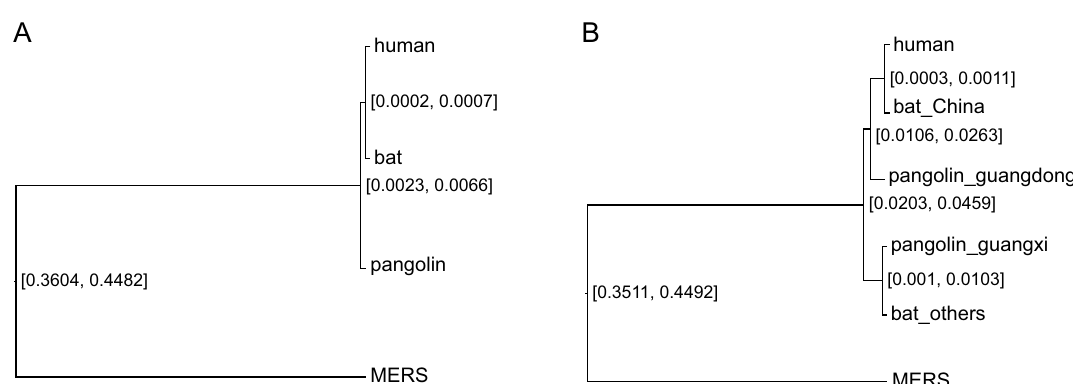
Figure 3. Bat and pangolin coronaviruses from the same location are more closely related than those from elsewhere. ( a ) The Bayesian species tree for human, bat, pangolin, and MERS coronavirus from StarBeast (Materials and Methods). ( b ) The Bayesian species tree for human, bat_China, bat_others, pangolin_guangdong, pangolin_guangxi, and MERS coronavirus from StarBeast. The numbers at the internal nodes of the species tree are 95% highest posterior density (HPD) interval for the depth of the internal node. The lower bound on the time of divergence of bat, human, and pangolin coronaviruses is (.0023/3)/(0.0002) = 4 year, using a 1/3 of a year as the length of the early pandemic as a calibration point for the lower bound in variation of 0.0002 in humans in panel A. The time of divergence of bat, human, and pangolin coronaviruses is (0.0041/3)/(0.0004) = 3.42 year, using a 1/3 of a year as the length of the early pandemic and the posterior mean branch lengths of the (pangolin, (human, bat)) node of .0041 and the (human, bat) node of